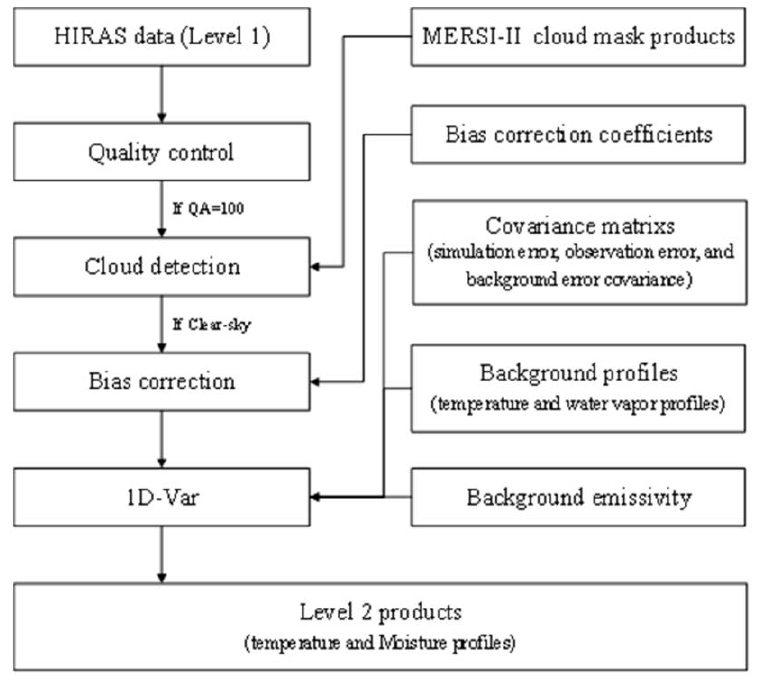
Figure 3. The complete flow chart of the HASS algorithm. The background emissivity, observation error, and bias correction coefficients depend on the simulated spectrum of matched clear-sky analysis dataset between the HIRAS and ERA5 data. The emissivity for a rough sea surface was calculated by an improved model [34]. The average emissivity for every selected channel can be seen in Figure 4d. The observation error is composed of the instrument error and the forward model error. The instrument error (see Figure 5a) is extracted from the theoretical noise equivalent differential temperature, while the forward model error (see Figure 5b) is calculated by the statistical analysis of differences between the observed spectrum and simulated spectrum [35]. For simplicity, the observation error matrix was assumed to be a diagonal matrix. The detail of the bias correction coefficients can be found in Section